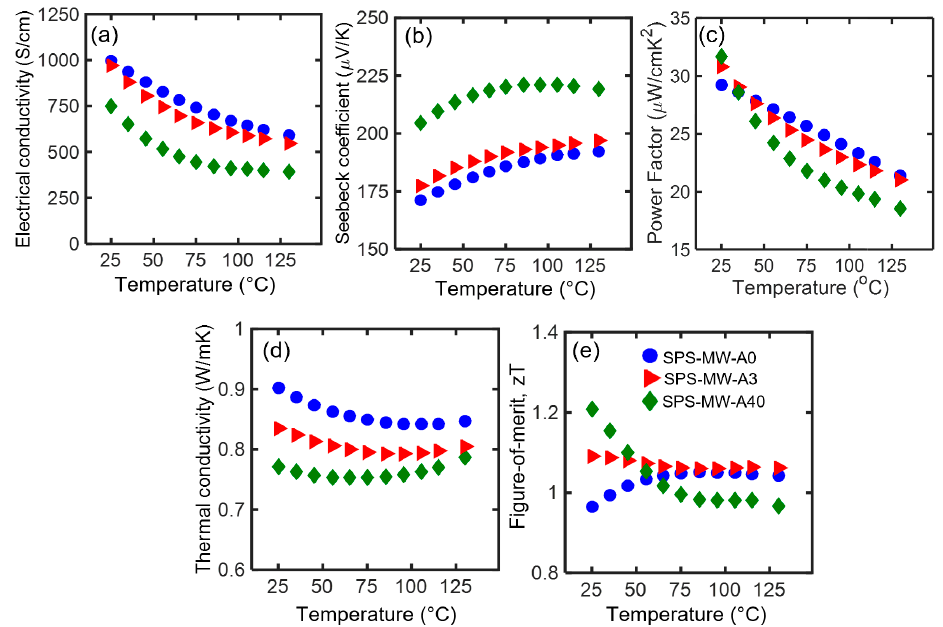
Figure 6. Comparison of ( a ) electrical conductivity, ( b ) Seebeck coefficient, ( c ) PF, ( d ) thermal conductivity, and ( e ) zT of spark plasma sintering (SPS)-MW-A0, SPS-MW-A3, and SPS-MW-A40 samples. The sample names are defined in Table 2. samples. The sample names are defined in Table 2.